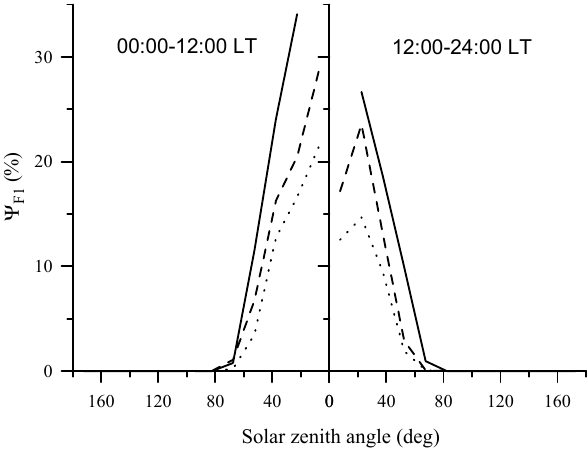
Fig. 1. The dependence of the F1-layer percentage occurrences on the solar zenith angle in latitude range 1 ( | 8 | ≤ 10 ◦ ) during the winter (solid lines), summer (dashed lines), and spring and autumn (dotted lines) months. The 0 ◦ − 180 ◦ solar zenith angle range in- cludes the local time period from 00:00LT to 12:00LT (left panel) and from 12:00LT to 24:00LT (right panel).